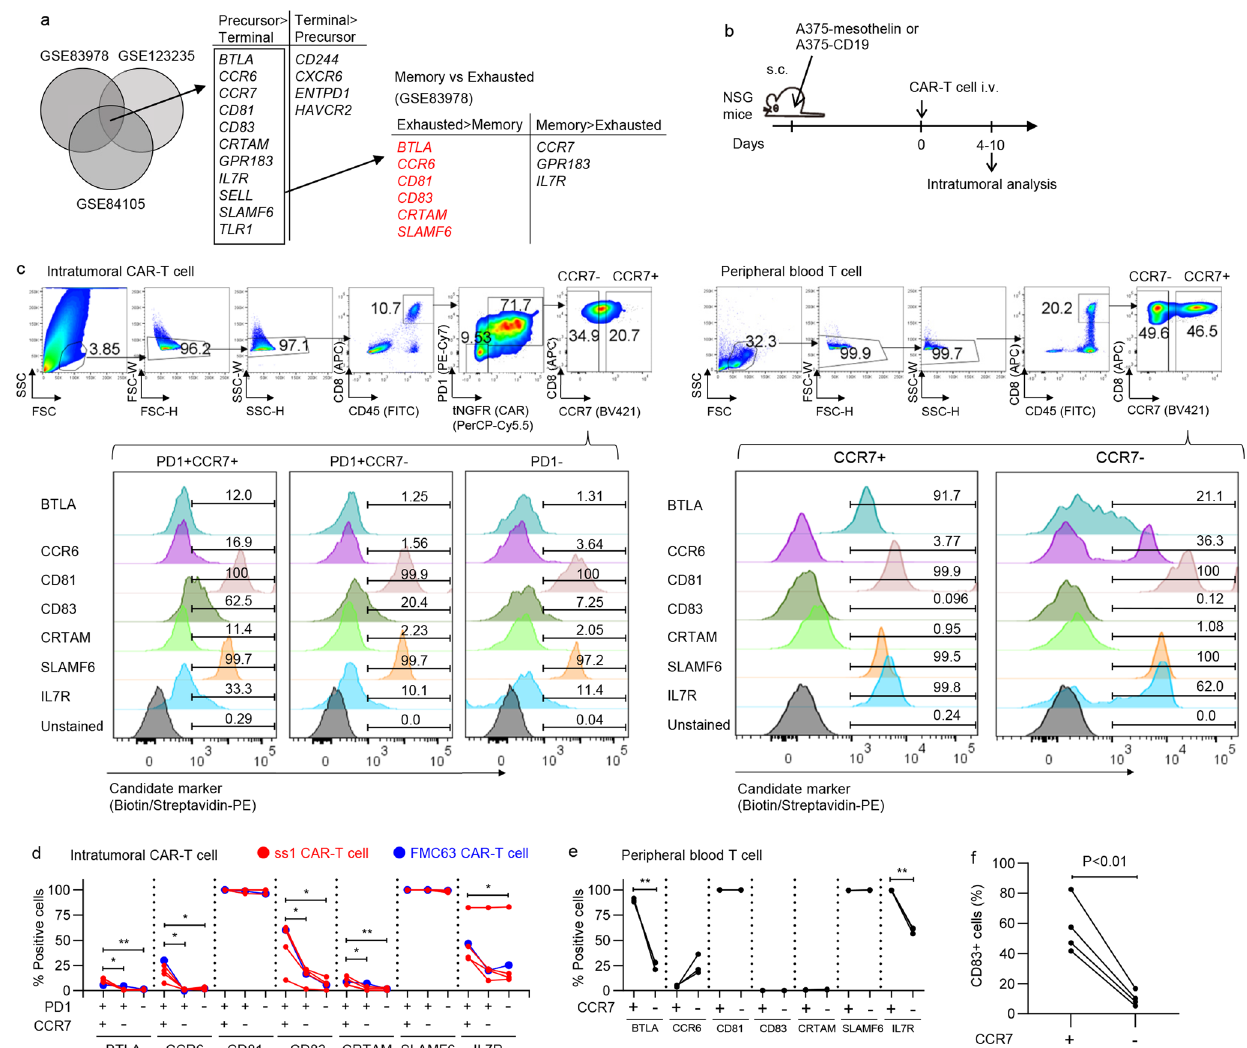
Fig. 2 CD83 is predominantly expressed in the precursor exhausted T cells. a Extraction of the candidate surface marker genes with predominant expression in a precursor exhausted T cell population compared with the terminally exhausted or non-exhausted memory T cells. b – d NSG mice were subcutaneously inoculated with A375-mesothelin or A375-CD19 and then treated with CAR-T cells. c Representative fl ow cytometry plots analyzing the expression of individual molecules in the tumor-in fi ltrating T cells and peripheral blood T cells. Gating threshold for each molecule was determined based on the plots of the fl uorescence minus one (FMO) control samples. d , e The frequency of cells that express the indicated molecules in the CCR7 + PD1 + , CCR7 - PD1 + , and PD1 − T cell population within the tumor ( d ), ( n = 5 samples from different mice, repeated measures one-way ANOVA with multiple comparison test) and in the CCR7 + / − peripheral blood T cells ( e ), ( n = 3 different samples, two-tailed paired t -test). * P < 0.05, ** P < 0.01. f CD83 expression in the CCR7 + / − intratumoral CAR-T cells was analyzed in the additional four mice using the A375-mesothelin model ( n = 4 samples from different mice, paired two-tailed t